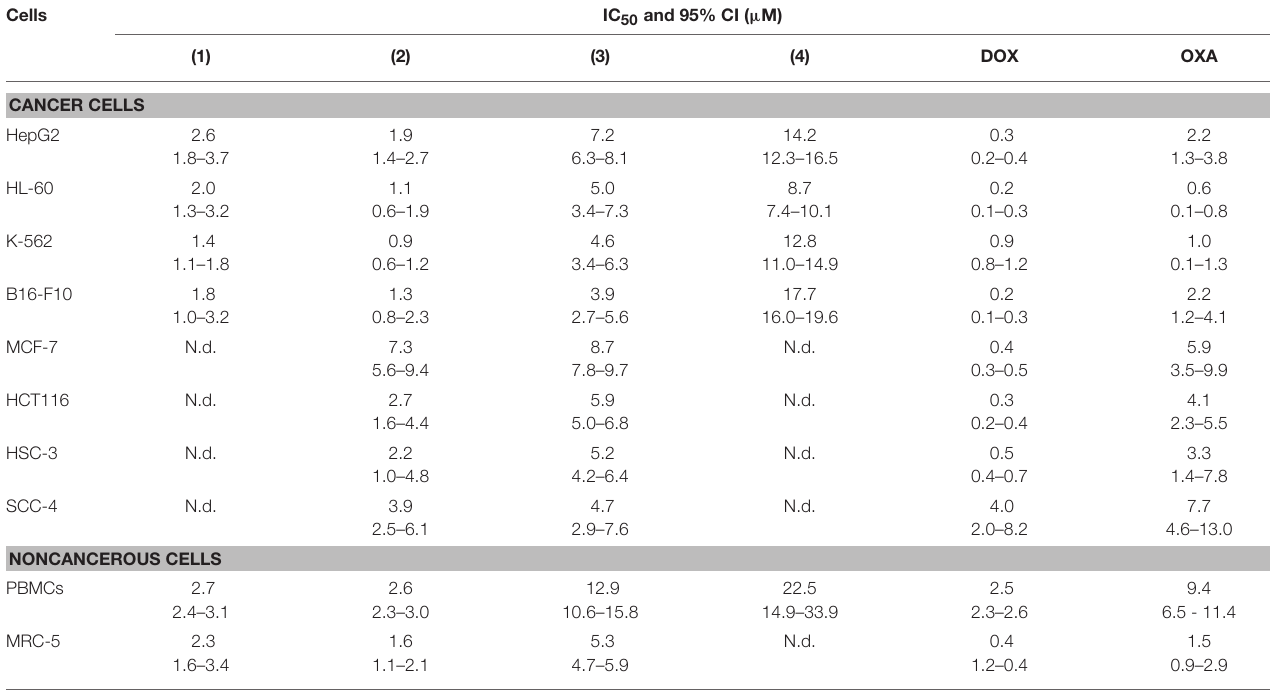
TABLE 1 | Cytotoxic activity of ruthenium complexes containing heterocyclic thioamidates.